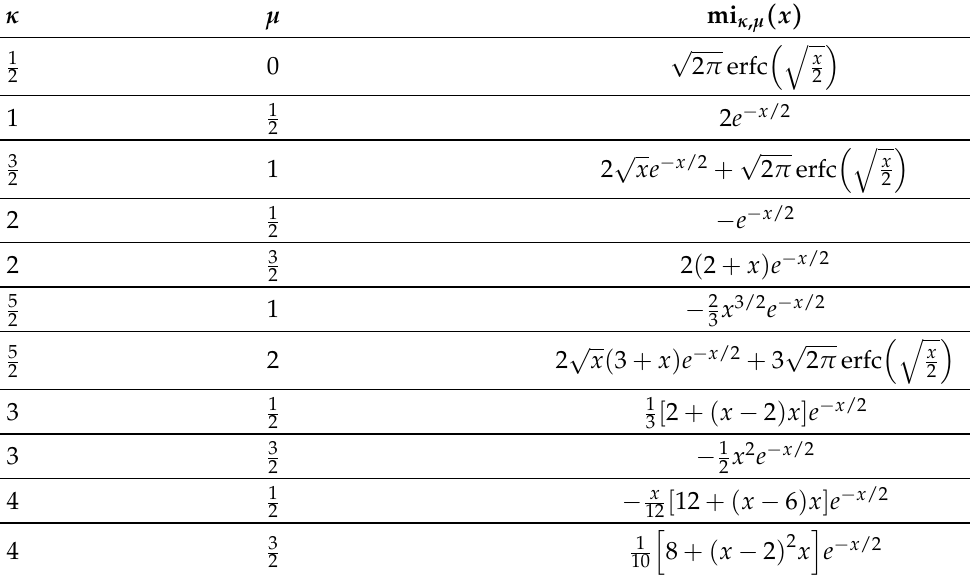
Table 7. The integral Whittaker functions mi κ , µ derived for some values of parameters κ and µ by using (18) and